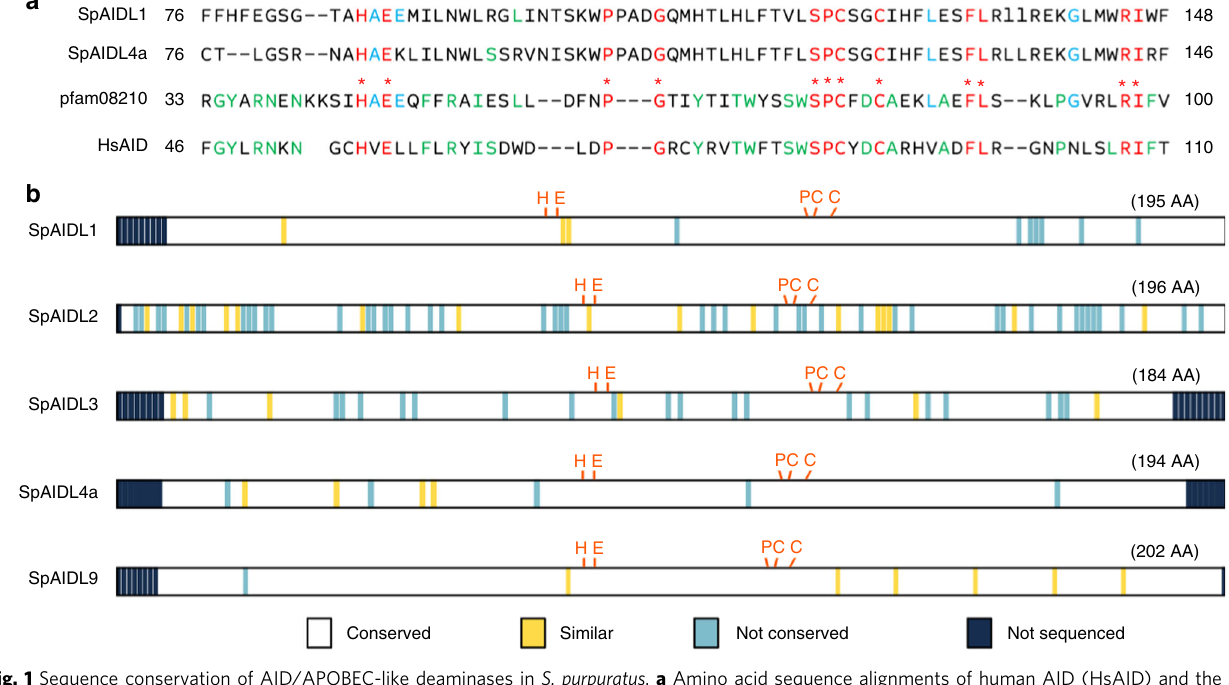
Fig. 1 Sequence conservation of AID/APOBEC-like deaminases in S. purpuratus . a Amino acid sequence alignments of human AID (HsAID) and the S. purpuratus SpAIDL1 and SpAIDL4a with the pfam08210 APOBEC-like N-terminal domain present in all vertebrate AID/APOBEC polynucleotide deaminases. Absolutely conserved residues including the catalytic HxE-PCxxC motif are shown in red, while conservation limited to HsAID or SpAIDL1/4a and pfam08210 are indicated in green or blue, respectively. b Schematic representation of the open reading frames of SpAIDL1, 2, 3, 4a, and 9 encoded by alleles from three unrelated individuals. Regions where the PCR primers precluded obtaining sequences are marked in dark blue, and the location and nature of polymorphisms are